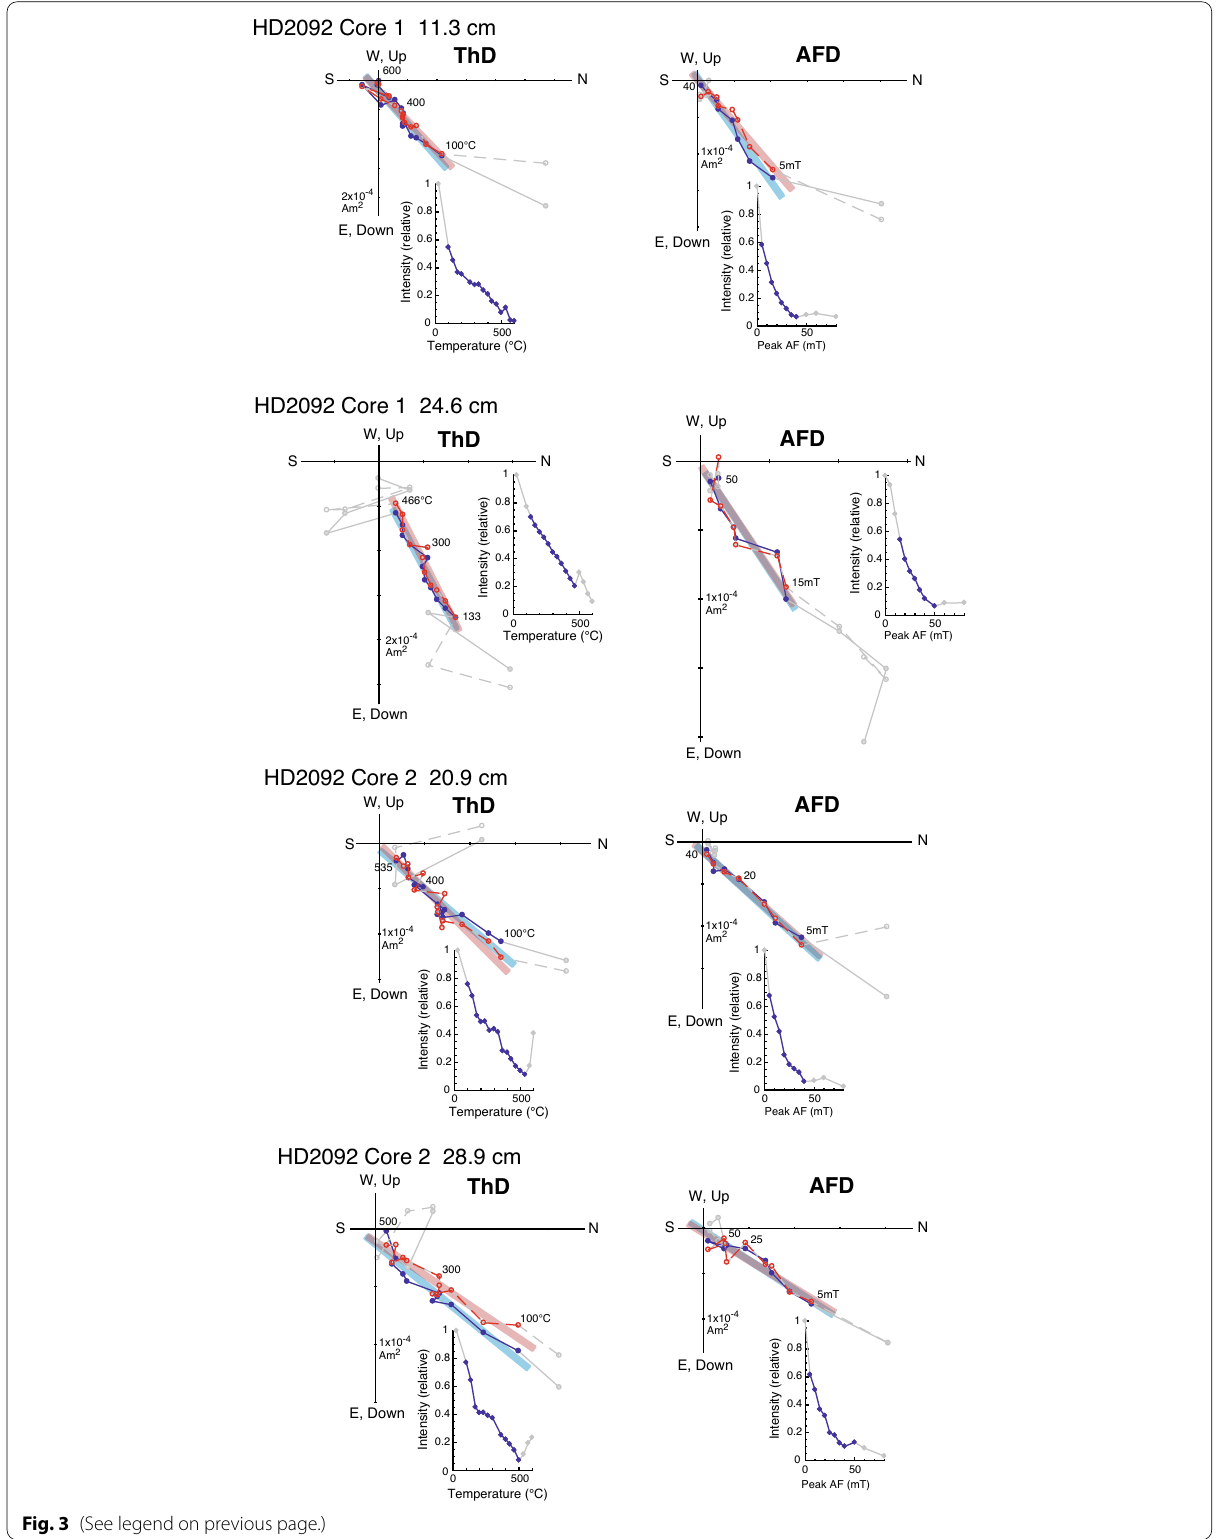
Fig. 3 (See legend on previous